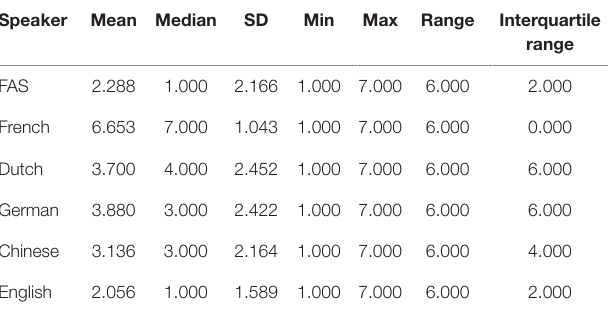
taBLe 6 | perceptual accent rating experiment: mean score, median, sD, minimum (Min), maximum (Max), range, and interquartile range for the patient and each of the control